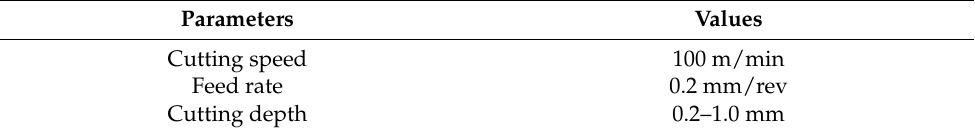
Table 5. Process parameters.